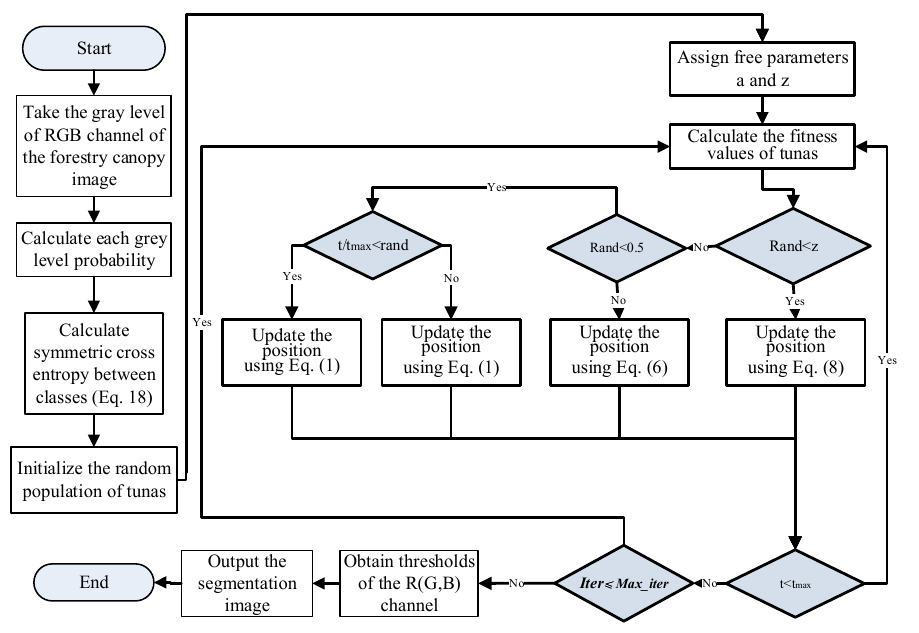
Figure 2. The flow chart of